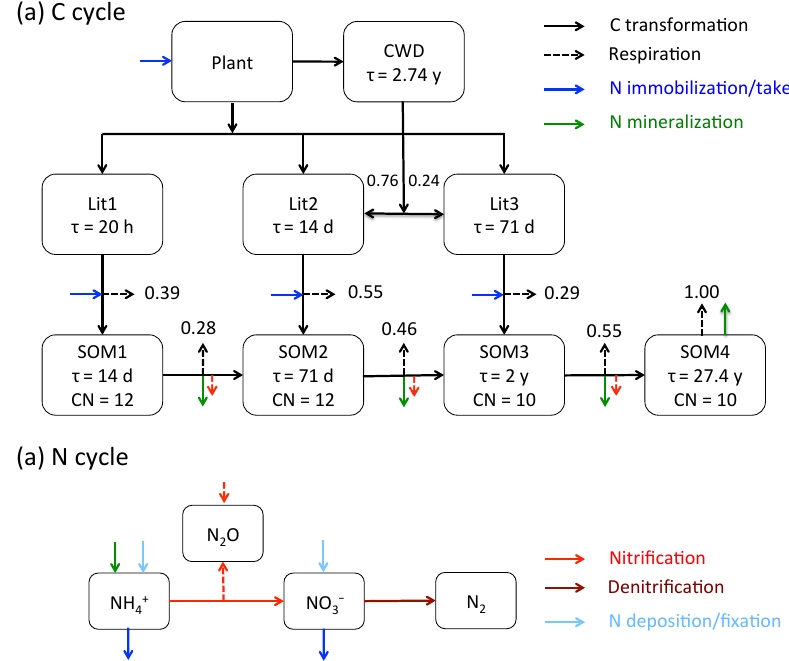
Figure 1. The reaction network for the carbon (a) and nitrogen (b) cycles implemented in this work. The carbon cycle is modified from Thornton and Rosenbloom (2005) and Bonan et al. (2012). τ is the turnover time, and CN is the CN ratio in gC over